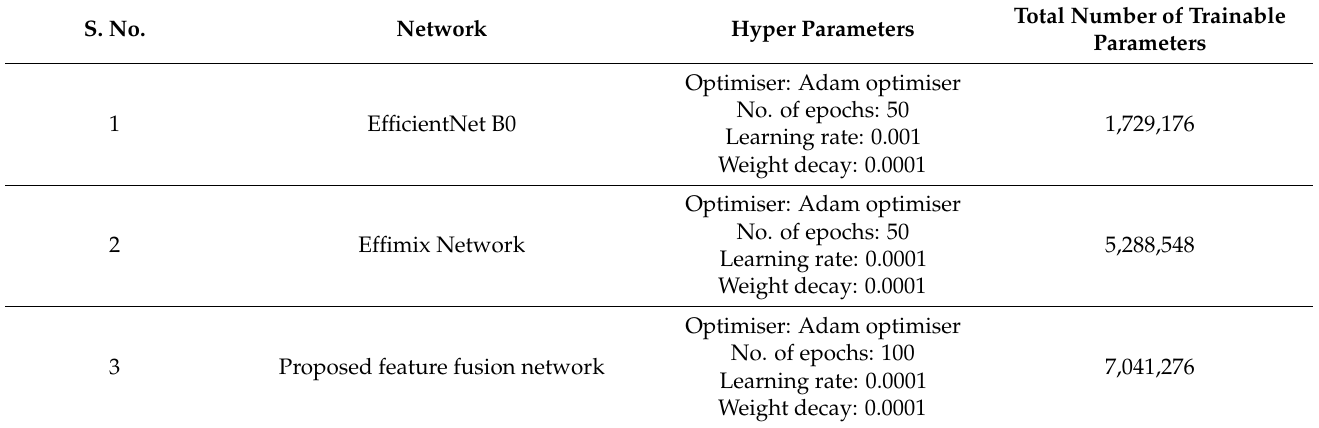
Table 4. Model parameters of the networks